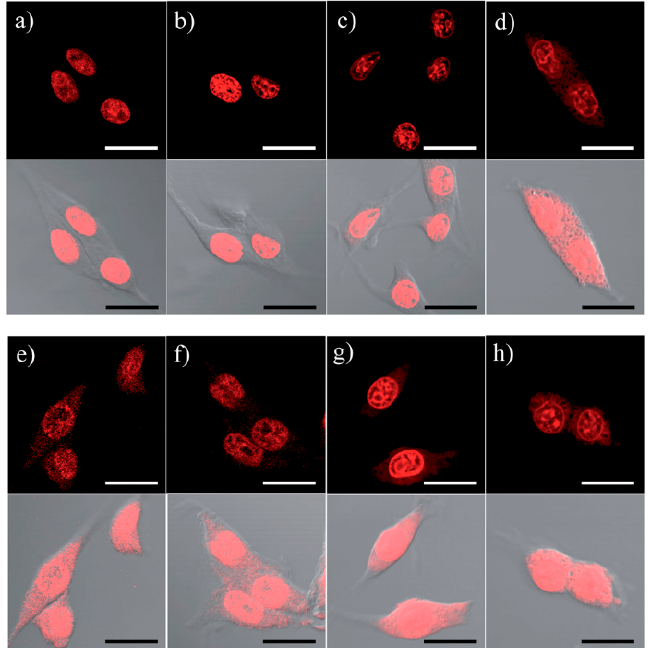
Figure 6. Confical laser scanning microscopic images of B16F1 cells showing the different drug delivery patterns after treatment with epirubicin for ( a ) 10 min, ( b ) 1 h, ( c ) 12 h, ( d ) 24 h and with eqirubicin/NGO-HA complex for ( e ) 10 min, ( f ) 1 h, ( g ) 12 h, ( h ) 24 h, respectively. Reproduced with permission from [49]. Copyright Royal Society of Chemistry, 2014.